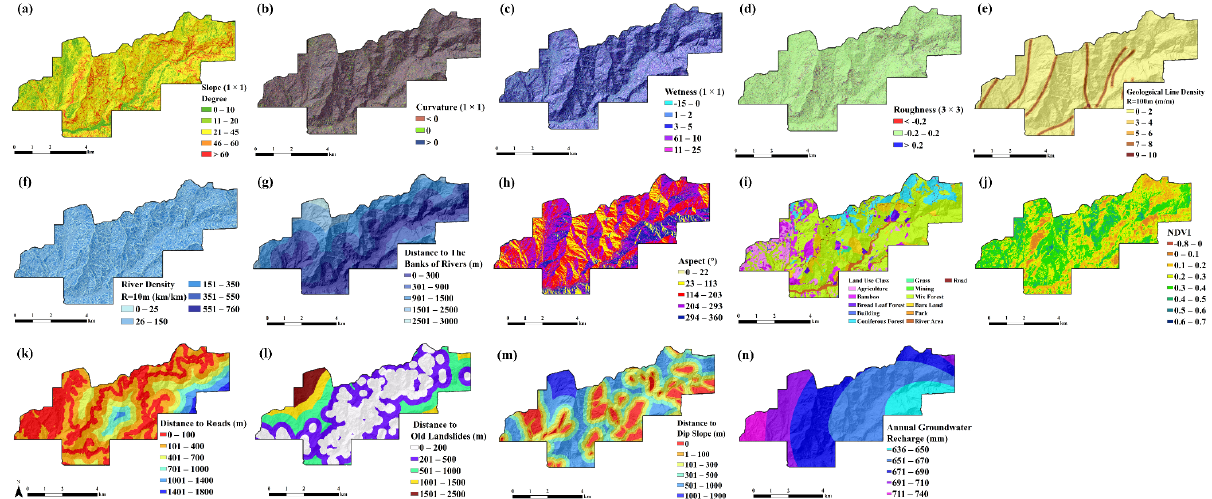
Figure 3. Variables used for landslide modeling in this study: ( a ) slope, ( b ) curvature, ( c ) wetness, ( d ) roughness, ( e ) geological line density, ( f ) river density, ( g ) distance to the banks of rivers, ( h ) distribution of slope aspect, ( i ) LULC types, ( j ) distribution of NDVI, ( k ) distance to roads, ( l ) distance to old landslides, ( m ) distance to the dip slope area, and ( n ) groundwater recharge.